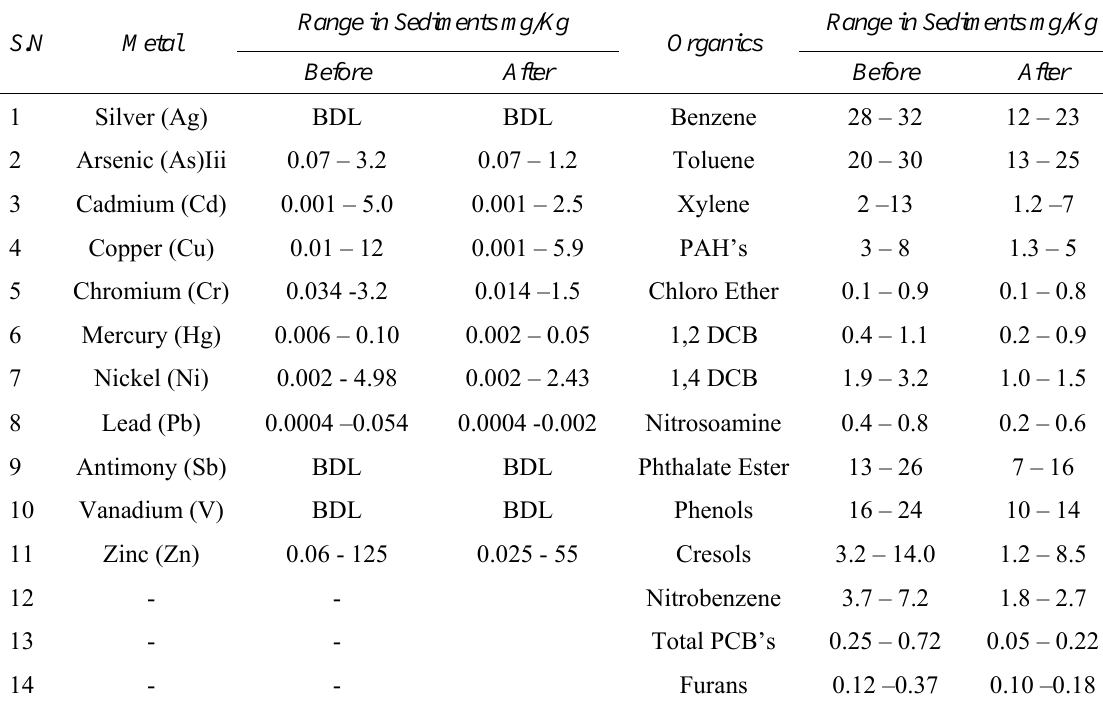
Range in Sediments mg/Kg